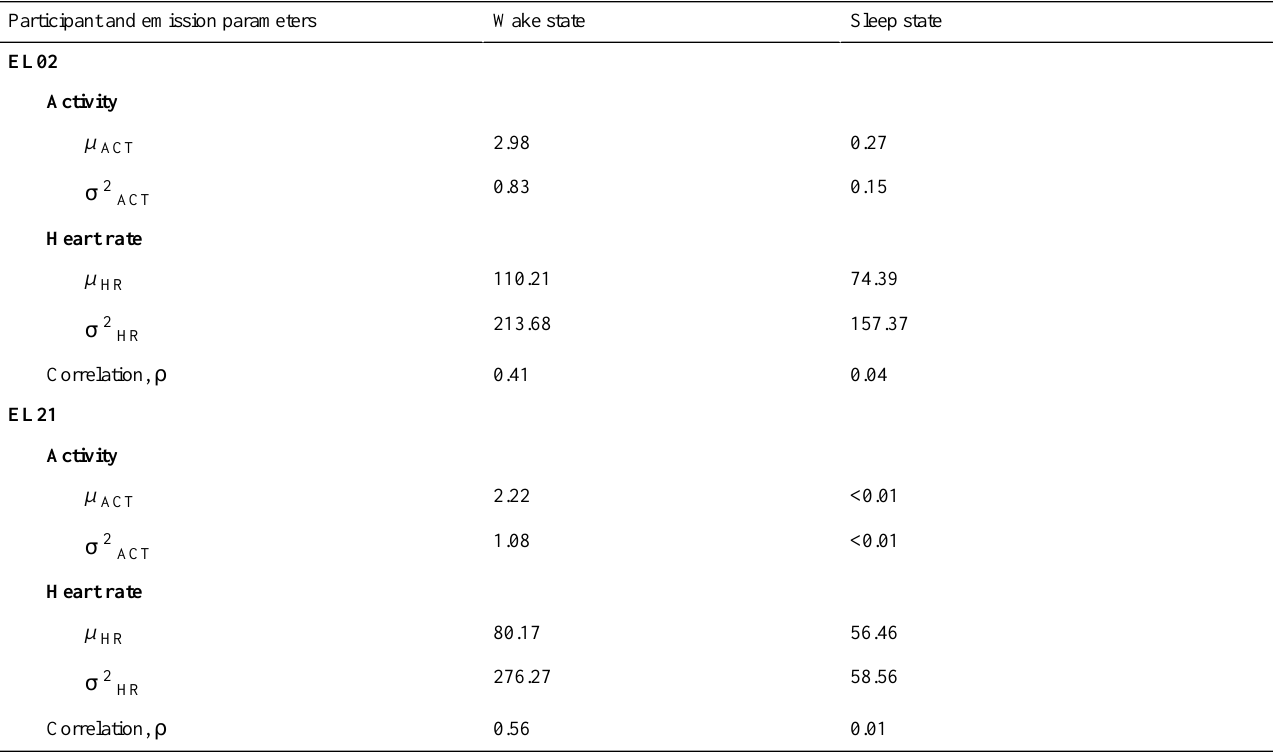
Table 2. Estimated parameters in model M2 for EL02 and EL21.